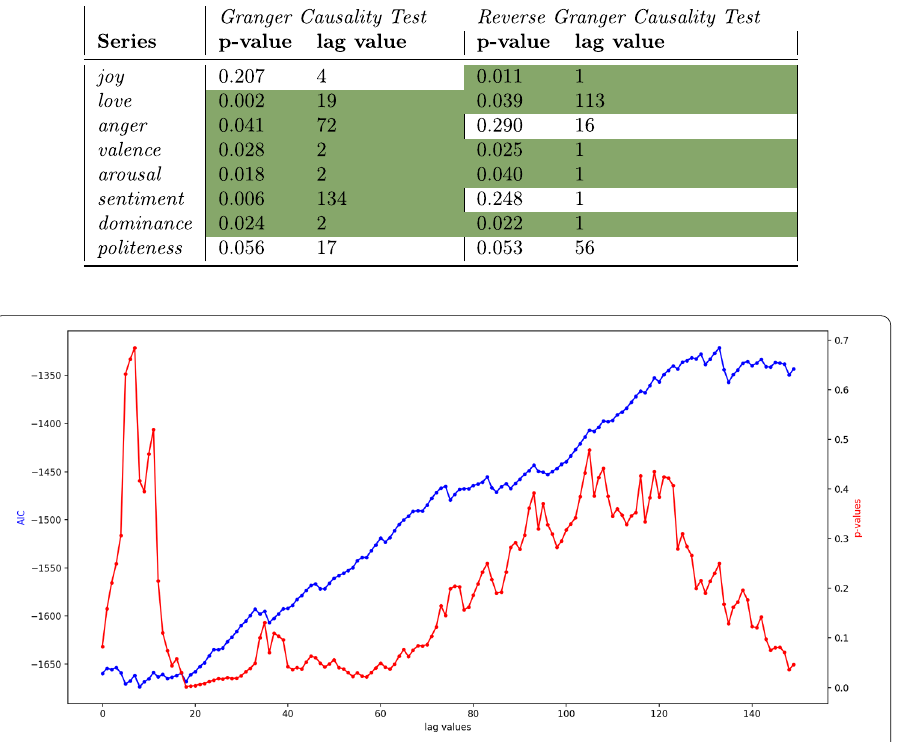
can be found for all affect metrics Granger-causing the Bitcoin returns in Sect. 2 of the Additional File 1. As for Bitcoin, we also estimate the time lag using the BIC criterion and results are provided in the Additional File 1 (Sect.